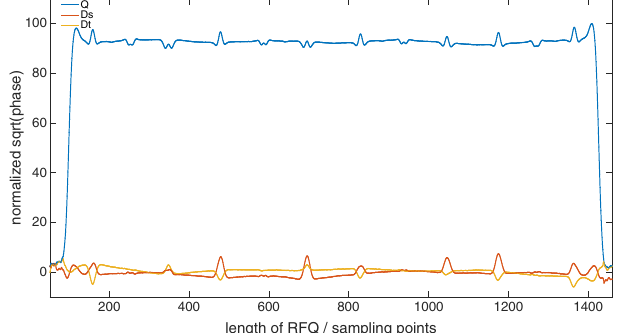
FIG. 18. The plot shows the detailed field distribution the of Q, Ds, and Dt components after field and frequency tuning. The horizontal axis shows the sampling points of the VNA instead of the longitudinal measurement location. This presentation allows to see the local field perturbations caused by the tuners.